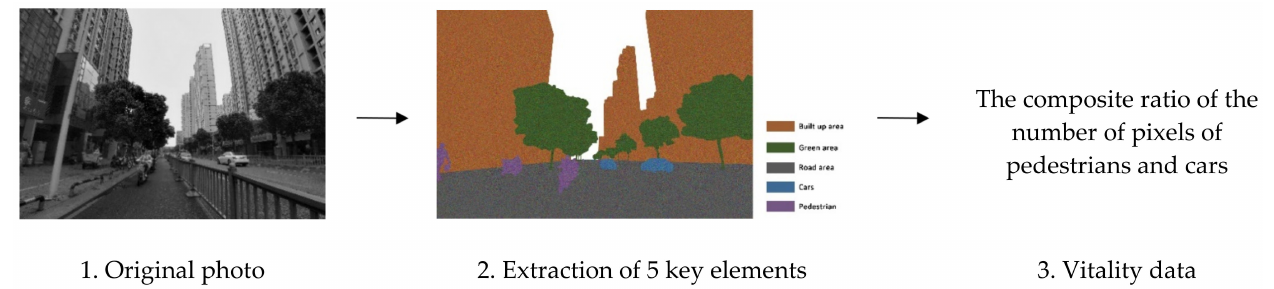
Figure 2. The image procession approach based on PSPNet and